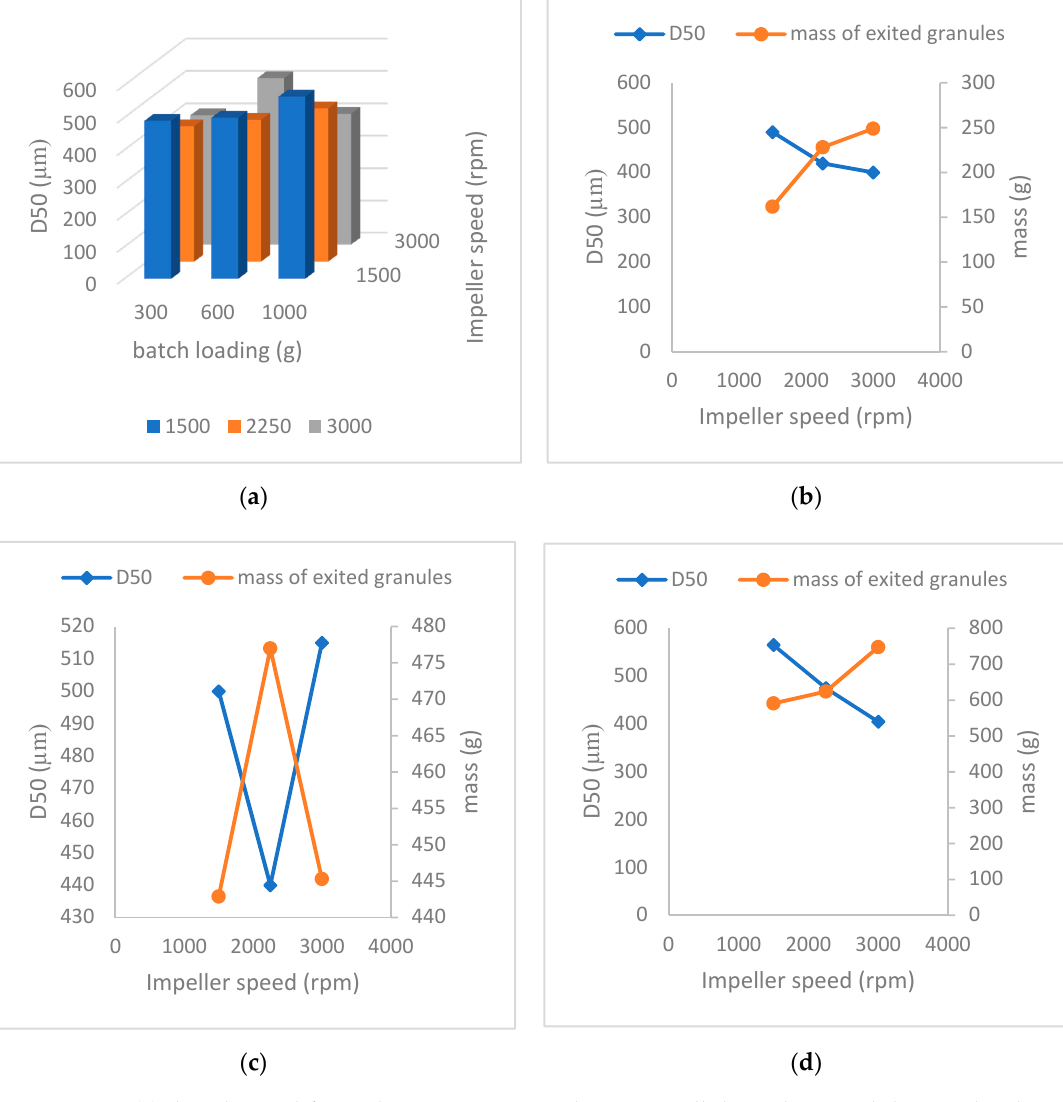
Figure 4. ( a ) d50 obtained for each run, comparison between mill throughput and d50 at a batch loading of ( b ) 300 g, ( c ) 600 g and ( d ) 1000 g.